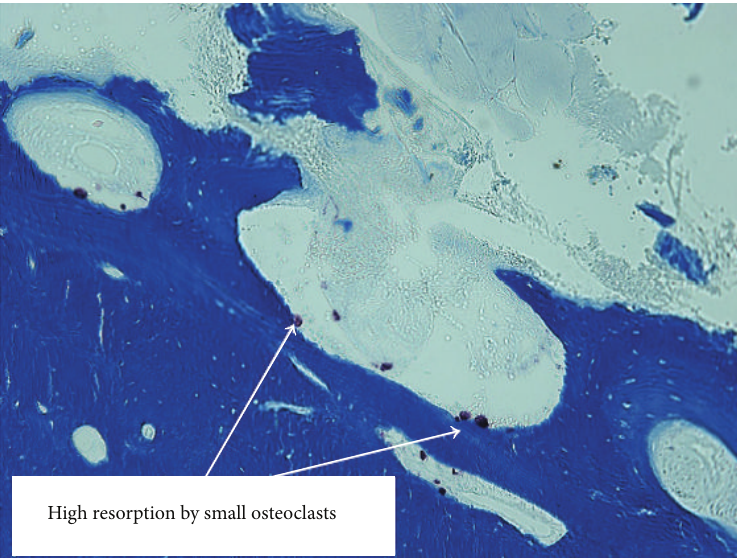
Figure 3: Bone biopsy of the iliac wing with double tetracycline labelling. Active, highly intense resorption via very small osteoclasts, especially in the periosteal